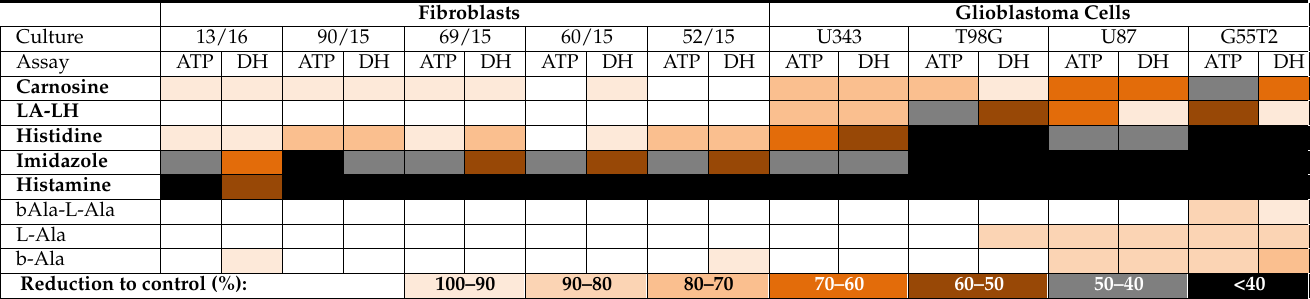
Figure 1. Viability of fibroblasts from culture 52/15 ( left ) and glioblastoma cells from the U343 line ( right ) after treatment with different compounds. Cells were treated for 48 h with carnosine (Car), L -alanyl- L -histidine (LA-LH), β -alanyl- L -alanine ( β A-LA), L -histidine (Histid), histamine (Hista), imidazole (Imid), L -alanine (LA), and β -alanine ( β A) (all 50 mM) or vehicle control (Contr) for 48 h. Cell viability was measured by determining ATP in cell lysates (upper panels) and dehydrogenase activity (DH) in living cells (lower panels). Results are presented as box plots. Statistical analysis was performed using a one-way ANOVA. The level of significance between different compounds is indicated by horizontal lines and compared to Contr above the boxes: *: p < 0.05; **: p < 0.005; ***: p < 0.0005; ns: not significant. Table 1. Effect of different compounds on viability of fibroblasts and glioblastoma